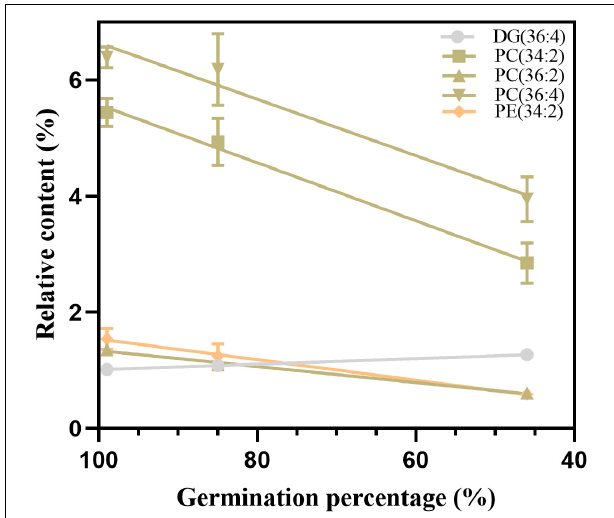
FIGURE 9 | The changes in five candidate lipids after 24 h of imbibition. Data shows the mean ± SD of six biologically independent experiments. Lipid molecular species are identified as total acyl carbons: total double bonds.